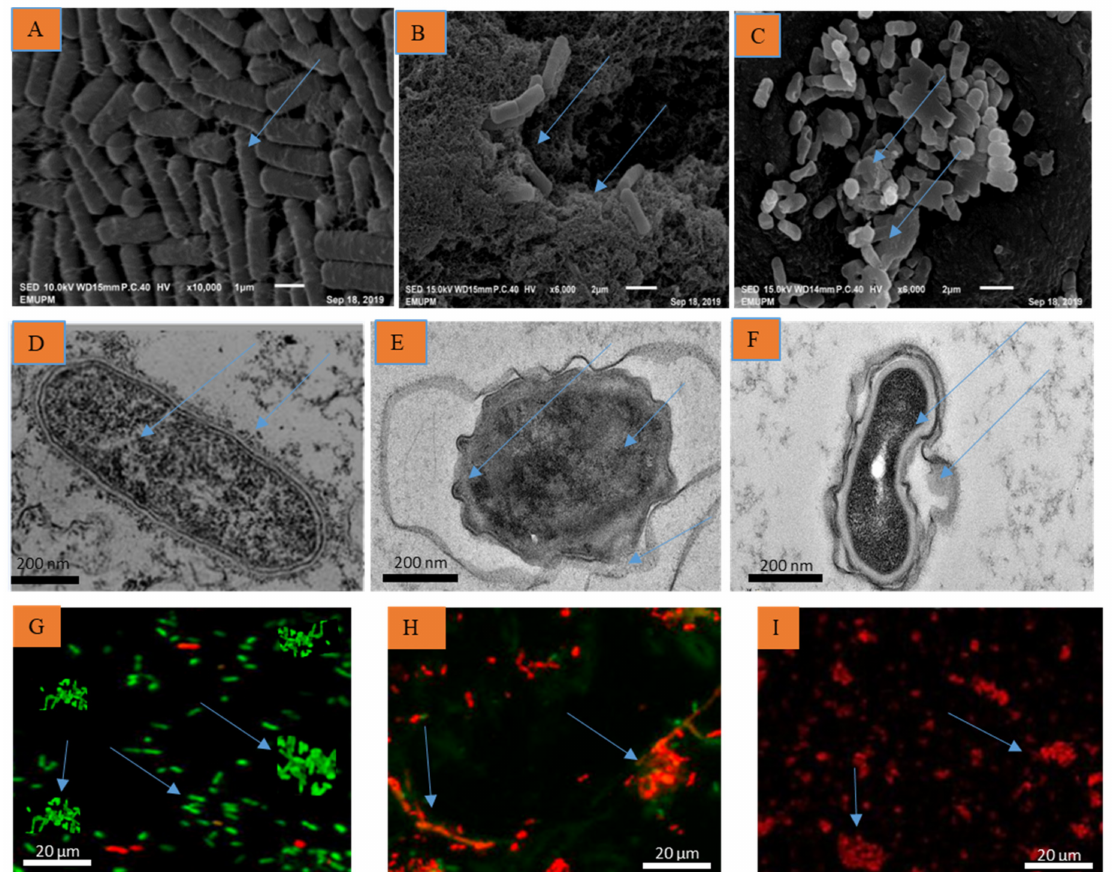
Figure 1. Mechanism of actions of ginger EOs against Xanthomonas oryzae pv. oryzae observed using SEM, TEM, and CLSM showing distinguished ultrastructural changes. ( A ) Untreated Xoo cells (control) with normal rod shape, smooth and bright surface, ( B ) Xoo cells treated with ginger EOs (100 µ L/mL) with irregular shape, sunken surfaces, disruption, and cell aggregation, ( C ) Xoo cells treated with streptomycin (15 g/mL) with an irregular cell growth, shrinkage, degradation, and coagulation, ( D ) Untreated Xoo cells with normal rod shape, ( E ) Xoo cells treated with ginger EOs (100 µ L/mL) and ( F ) streptomycin (15 g/mL) showed that the membrane cell was disrupted, resulting in permeability and the release of intracellular components, ( G ) Confocal laser scanning micrographs of untreated Xoo cells with noticeable green color indicated that the cells are alive and intact, ( H ) Treated Xoo cells with ginger EOs (100 µ L/mL) and ( I ) Streptomycin (15 µ g/mL) showed the biofilms formed with its disintegration coupled with red-stained cells, indicating that more dead cells